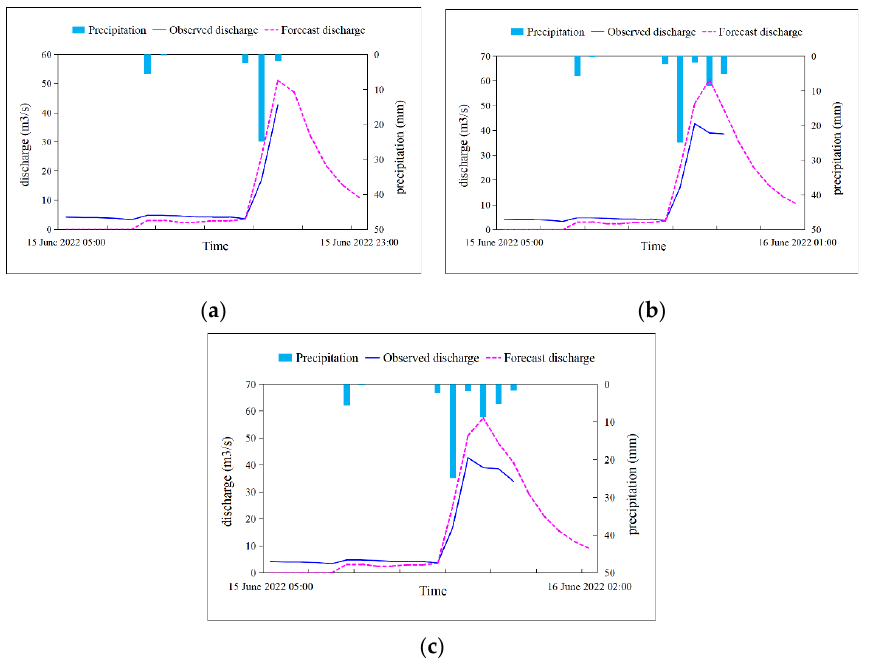
Figure 9. Three rounds of forecasts for the flood 15 June 2022. ( a ) First-round forecast results; ( b ) second-round rolling forecast results; and ( c ) third-round rolling forecast results.